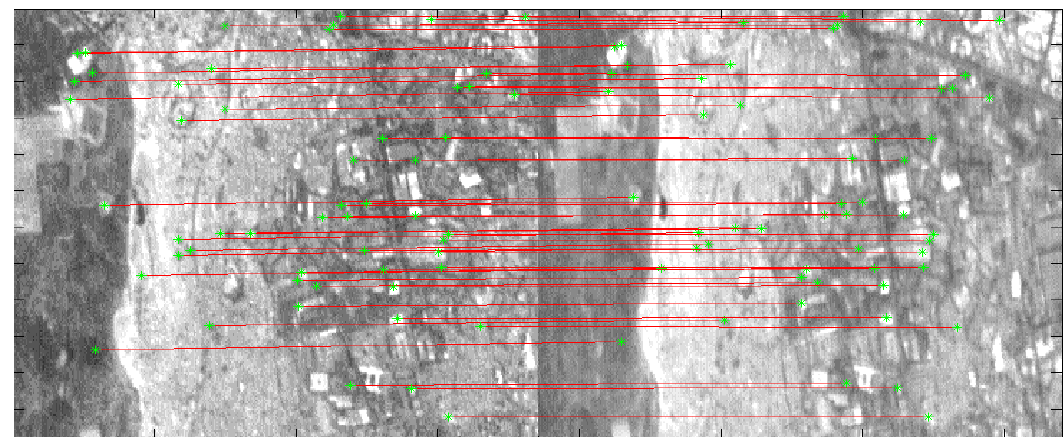
Figure 4: The correspondence points pruned by the fundamental matrix estimated using the proposed